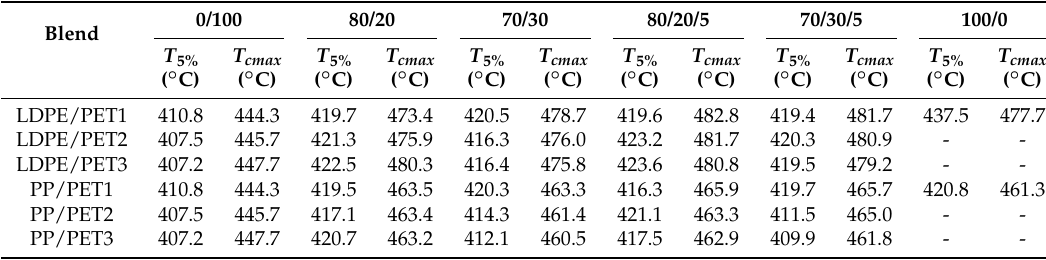
Table 4. The decomposition temperature ( T 5% ) and the corresponding temperature of the maximum decomposition rate ( T cmax ) of polymer